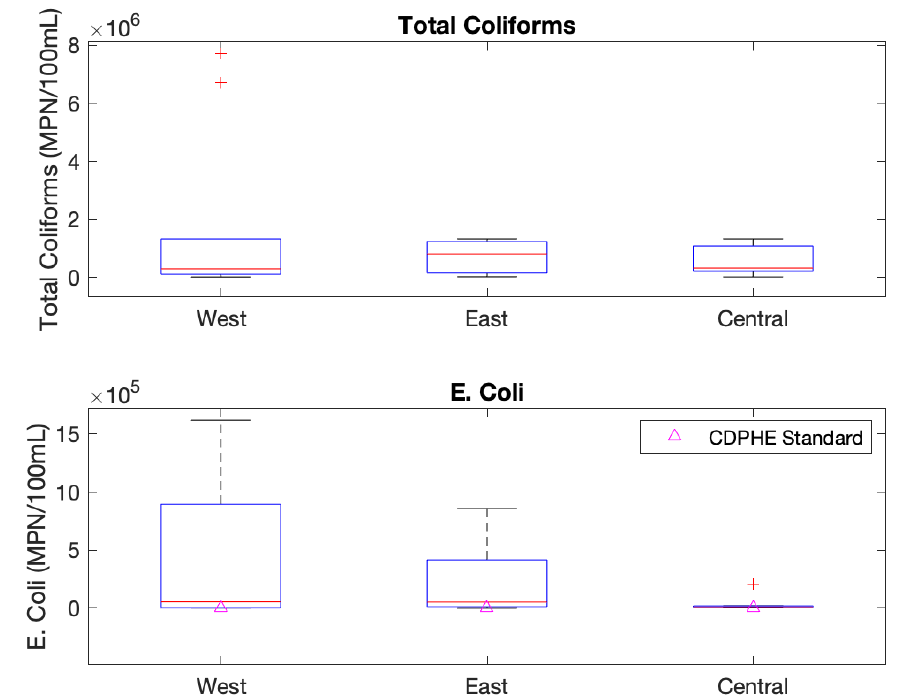
Figure A3. Wet weather water quality—total coliforms and E. coli . Red plus signs indicate outliers and triangles represent CDPHE in-stream standards, where relevant.